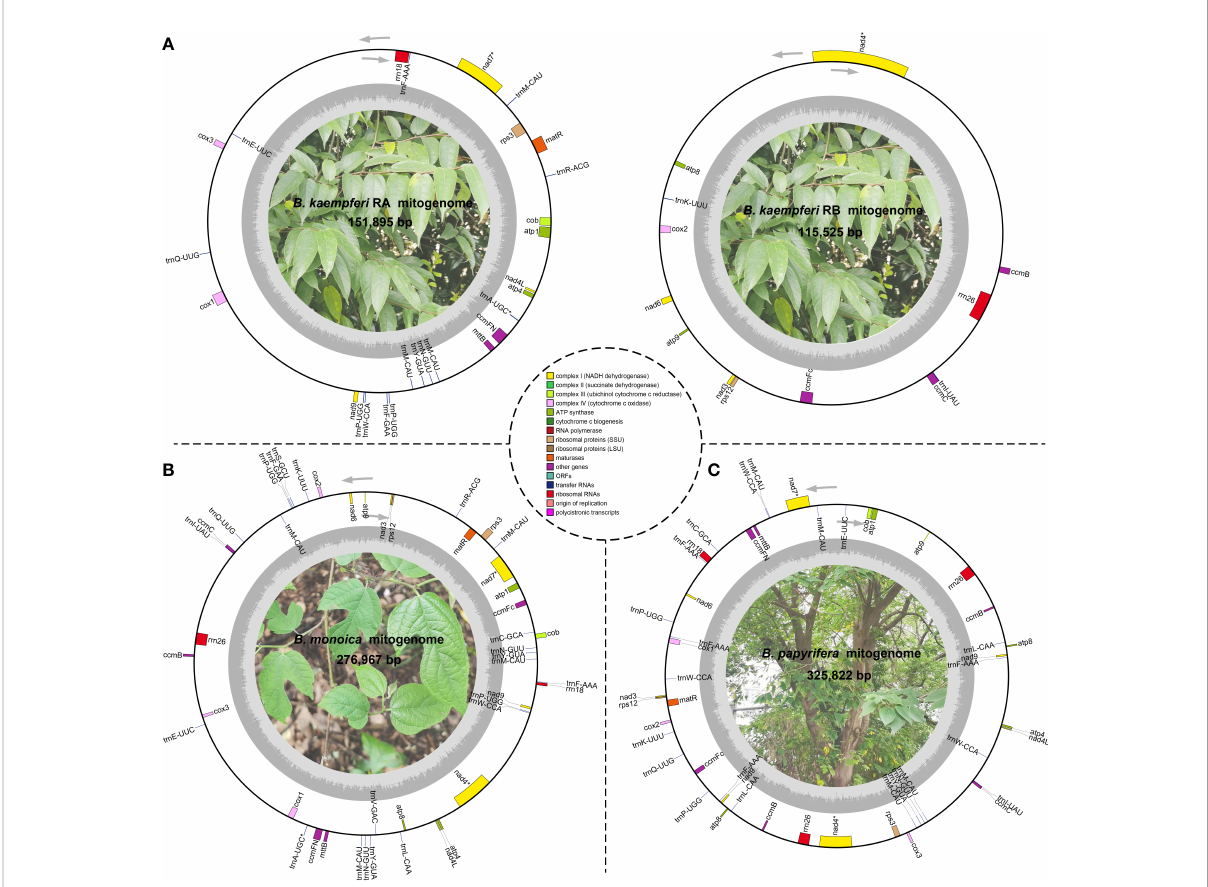
FIGURE 2 Schematic mitogenome diagram of three Broussonetia spp. in this study. (A) Two mitochondrial subrings (RA and RB) of B kaempferi . (B) B monoica . (C) B papyrifera . Genes belonging to different functional groups are color-coded. * indicates gene containing intron(s). nad2 and nad5 were trans splicing so they were not shown